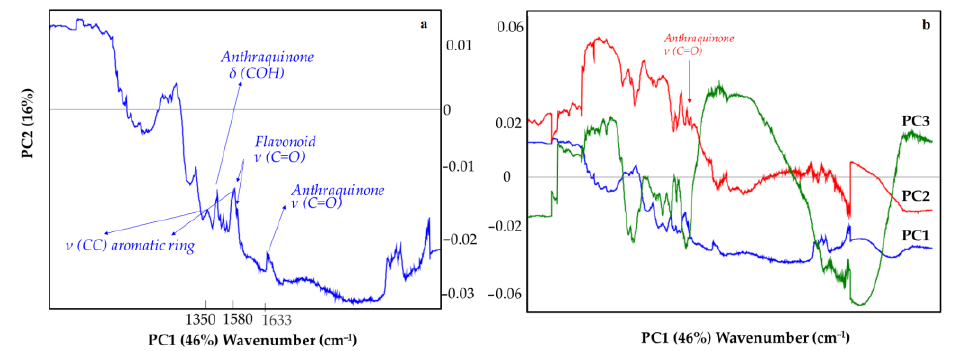
Figure 8. Loadings plot (variable distribution projection, wavenumber cm −1 ) in line plot for the PC1 visualization (to highlight the spectral regions generated by the first component) where some of the vibrational molecular modes for the organic pigments are shown. The variables are normalized at step 2 cm −1 on the entire energy spectrum (see ( b ) the Raman and ( a ) IR data treatment section).